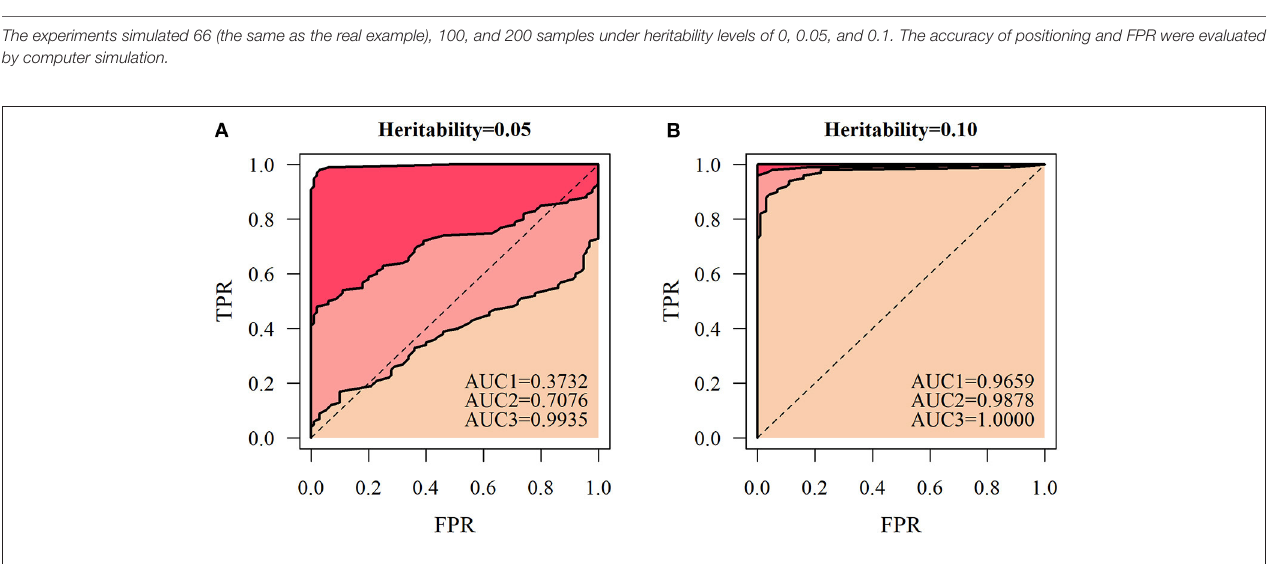
Frontiers in Plant Science |